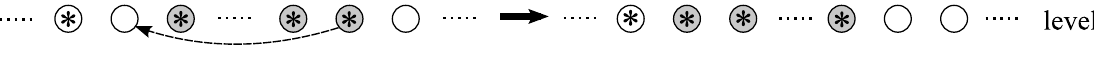
Figure 8. R EPAIR for a hole-level (cid:96) which is not a bottom of a tank.